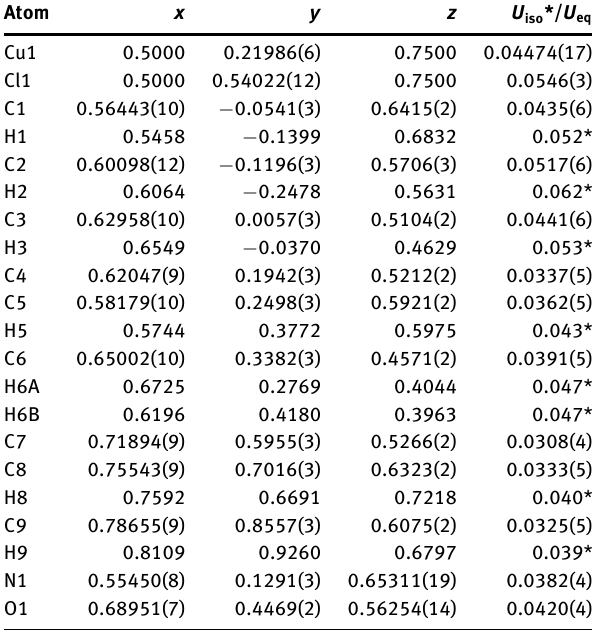
Table 2: Fractional atomic coordinates and isotropic or equivalent isotropic displacement parameters (Å 2